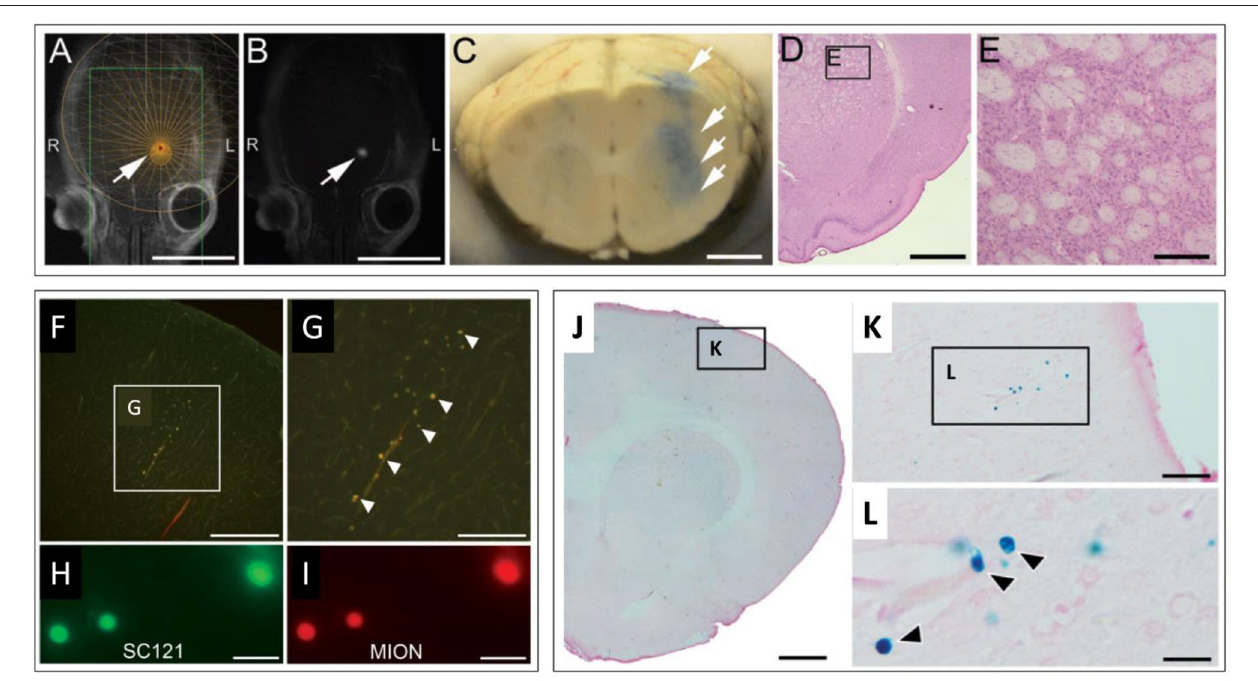
FIGURE 3 | MRgFUS mediated delivery of dual labeled (fluorescence & SPION) NPCs in the rodent brain. (A,B) Representative screen captures from an MRgFUS system graphic user interface. (A) T2 weighted axial MRI image of a rat brain showing treatment target (arrow) overlay. (B) T1 contrast MRI image showing hyperintense signal from gadolinium extravasation at location of treatment (arrow), indicating successful BBBO. Signal coincides with treatment target in “A”. (C) Whole brain coronal section indicating successful BBBO, evidenced by Evans blue dye (arrows) that extravasated in the region of the focal zone. (D) H&E stained brightfield histological section demonstrating unaffected tissue in the region of MRgFUS treatment. (E) higher magnification region from “D” (inset). (F–I) Fluorescence microscopy images of fluorescently labeled NPCs in the brain. (F) Fluorescently labeled NPCs in the dorsal cortex. (G) higher magnification of inset in “F”. (H) Fluorescent signals detected from labeled human cytoplasmic antigen (SC121). (I) Higher magnification of fluorescently labeled NPCs. Co-localization of fluorescent signals in “H” and “I” provide evidence that labeled cells are NPCs (human). (J–L) Brightfield microscopy images of Prussian blue stained histological sections (for SPION) indicating the presence of NPCs. (J) Low magnification image. (K) Inset in “J.” (L) Inset in “K.” Individual cells (blue) are seen (arrows). Scale bars: A, B = 10mm; C = 2mm; D = 2mm; E = 200 µ m; F = 400 µ m; G = 200 µ m; H, I = 20 µ m; J = 1mm; K = 50 µ m; L = 5 µ m. Adapted from Shen et al. Cell Transplantation 2017 (81). Reprinted with permission from SAGE